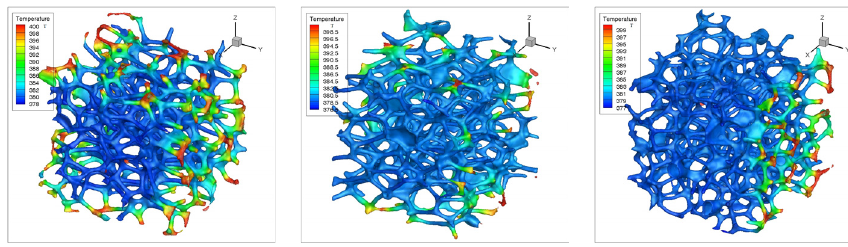
Figure 5. Global temperature distribution.